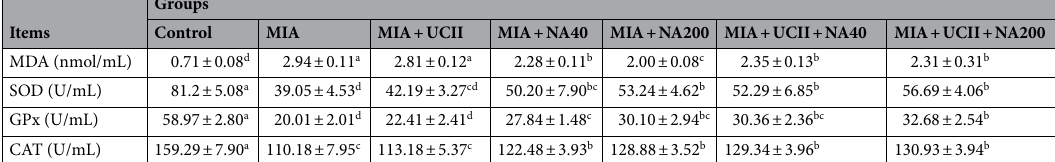
Table 5. Effects of niacinamide (NA) and undenatured type II collagen (UCII) supplementation on serum MDA and antioxidant enzymes levels in rats (n = 7). Data are presented as mean and standard deviation ( p > 0.05; ANOVA and Tukey’s post-hoc test). NA: niacinamide; MIA: monosodium iodoacetate; UCII: undenatured type II collagen; MDA, malondialdehyde; SOD, superoxide dismutase; CAT, catalase; GPx, glutathione peroxidase. NA40 and NA200 represent 40 and 200 mg/kg niacinamide dose applications, respectively. (a–d): Means in the same line without a common superscript differ